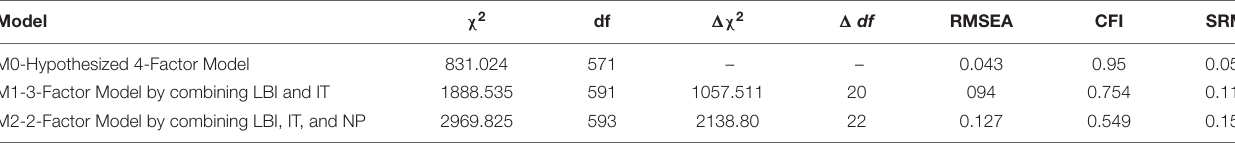
TABLE 1 | Fit indices of hypothesized model and alternative models. Model